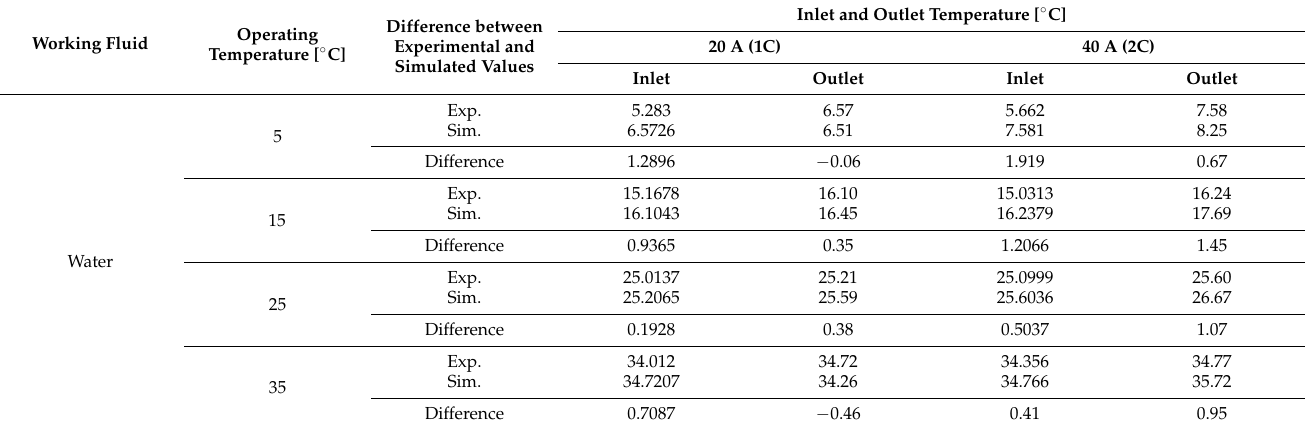
Table 3. Water inlet and water outlet temperature at 20 A and 40 A releasing currents and at various operating